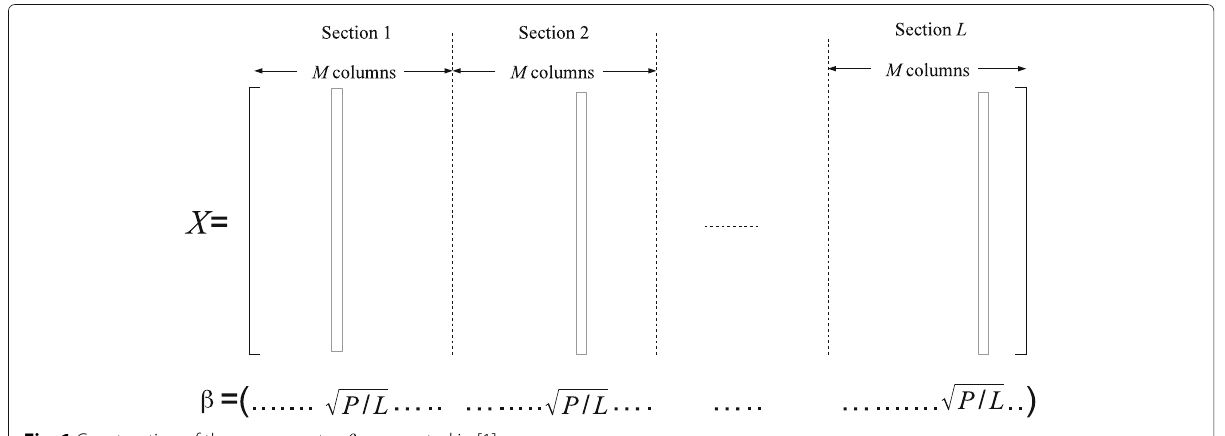
Fig. 1 Construction of the sparse vector β as reported in